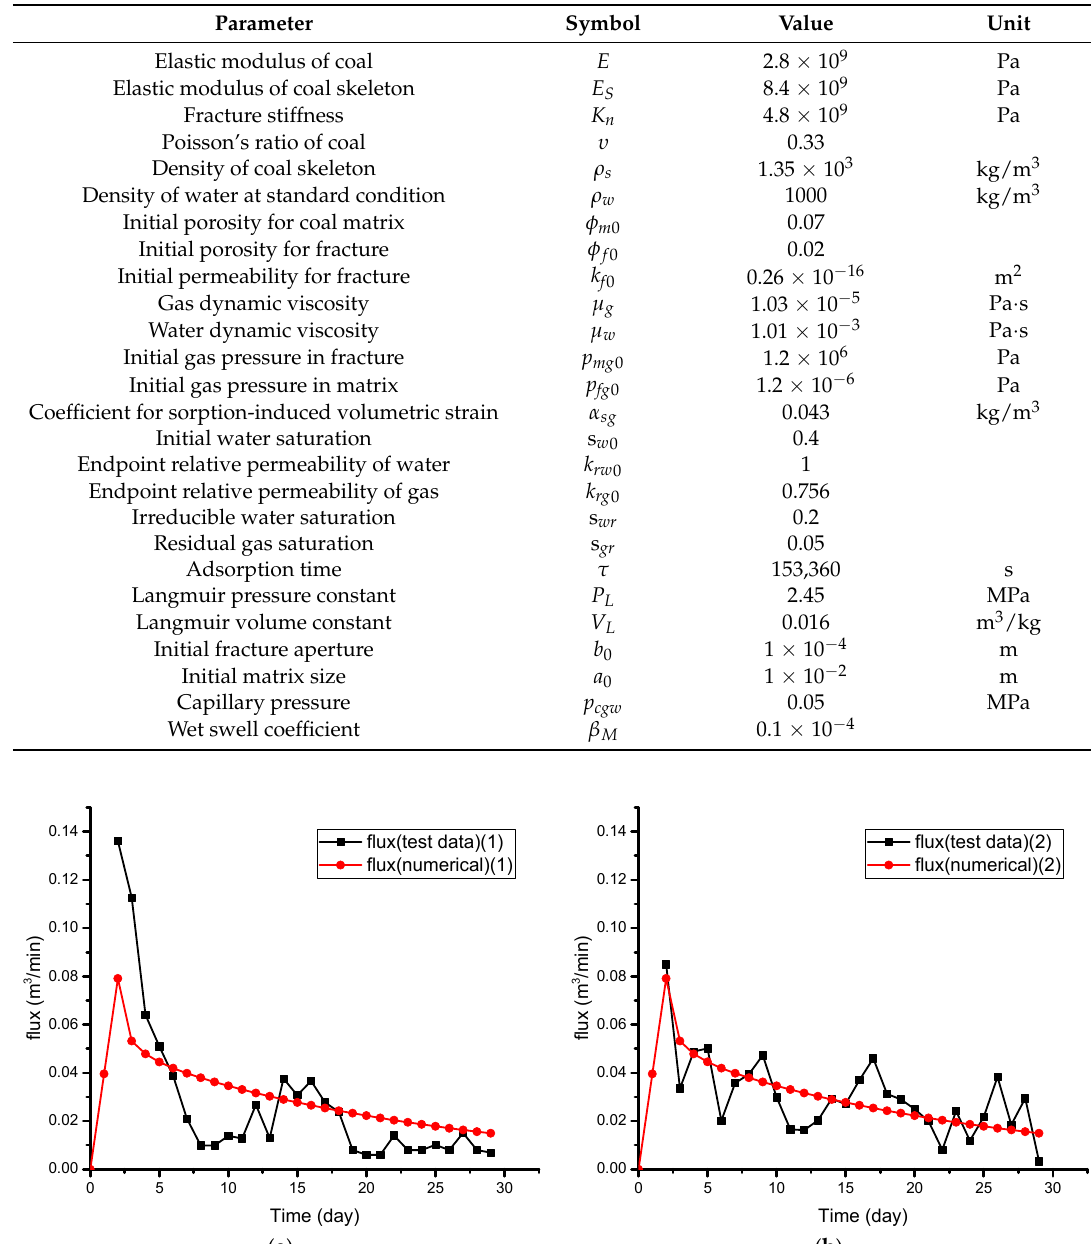
Table 1. The parameters for computational model.